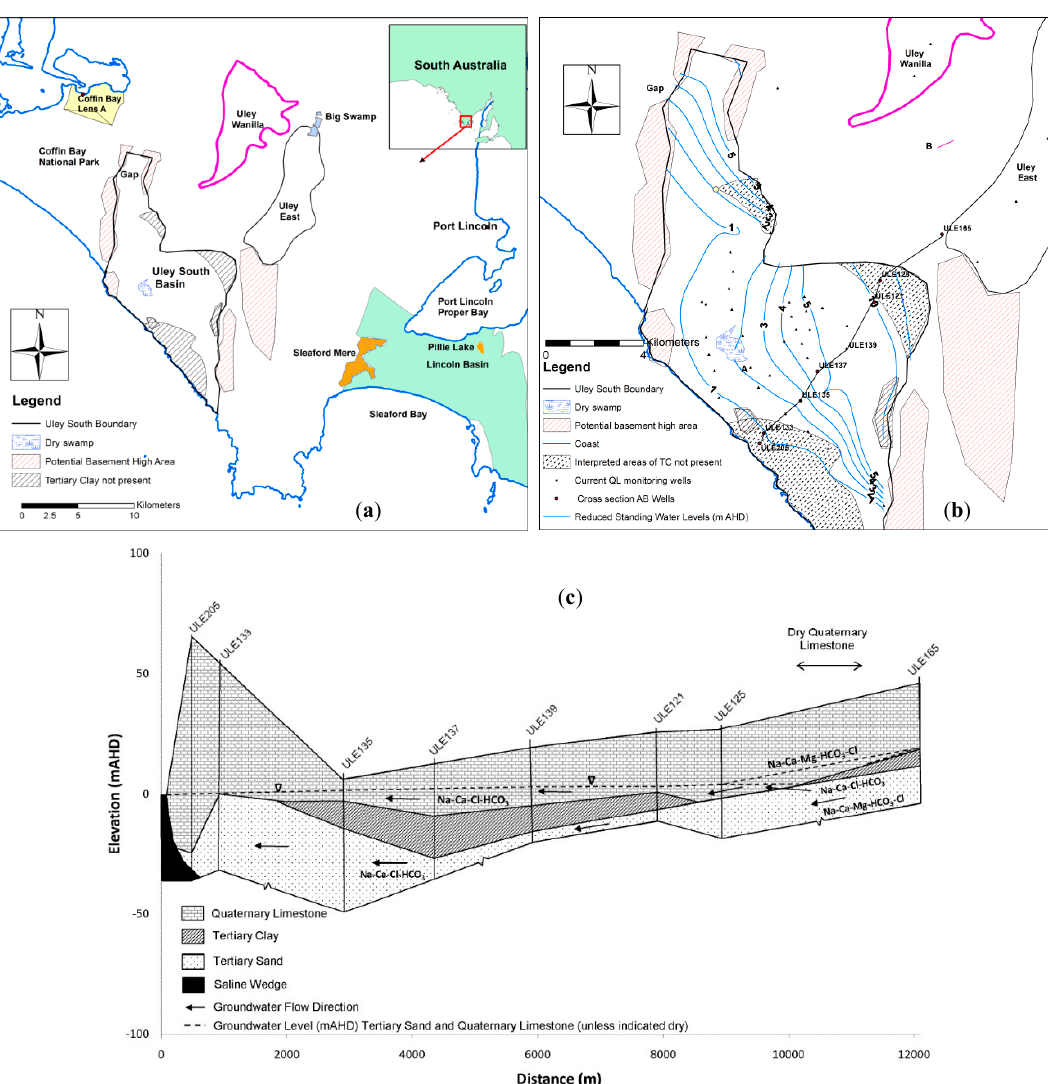
Figure 1. ( a ) Uley South basin with Coffin Bay Lens A, Uley Wanilla, Uley East, and Lincoln Basins; ( b ) Groundwater elevation contours; ( c ) Cross section AB [24,25].